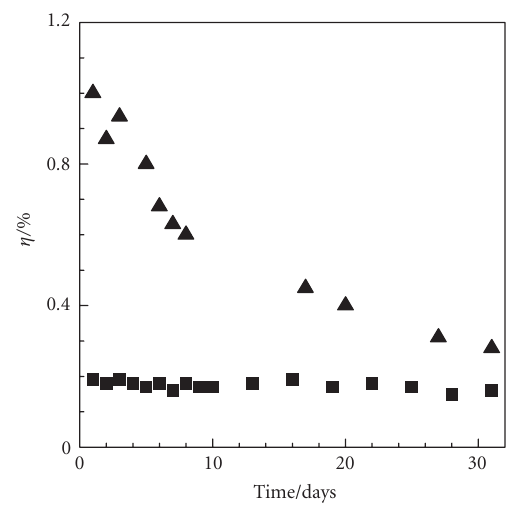
Figure 2: Thermogravimetric curves for P(EPI-EO)84 : 16 and P(EPI-EO)84 : 16 + 11wt% NaI / I 2 samples prepared by casting the polymer electrolyte under a saturated solvent